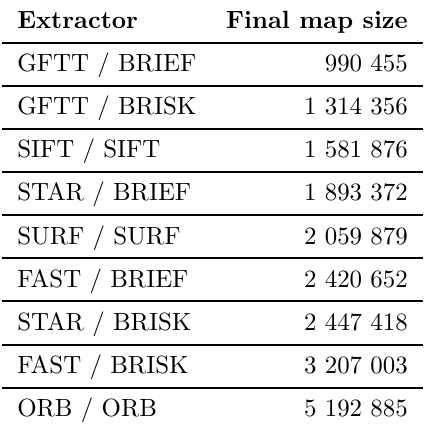
Table 2. The number of points contained in the map after completing the sequence for each evaluated extractor, in ascending order.